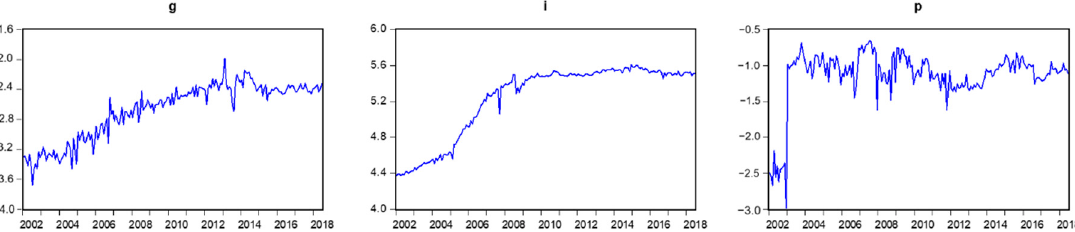
Figure 1. Plots of the variables (in logarithmic scale). notes: g, i, and p are gasoline demand and income, both in per capita terms, and real gasoline price, respectively.